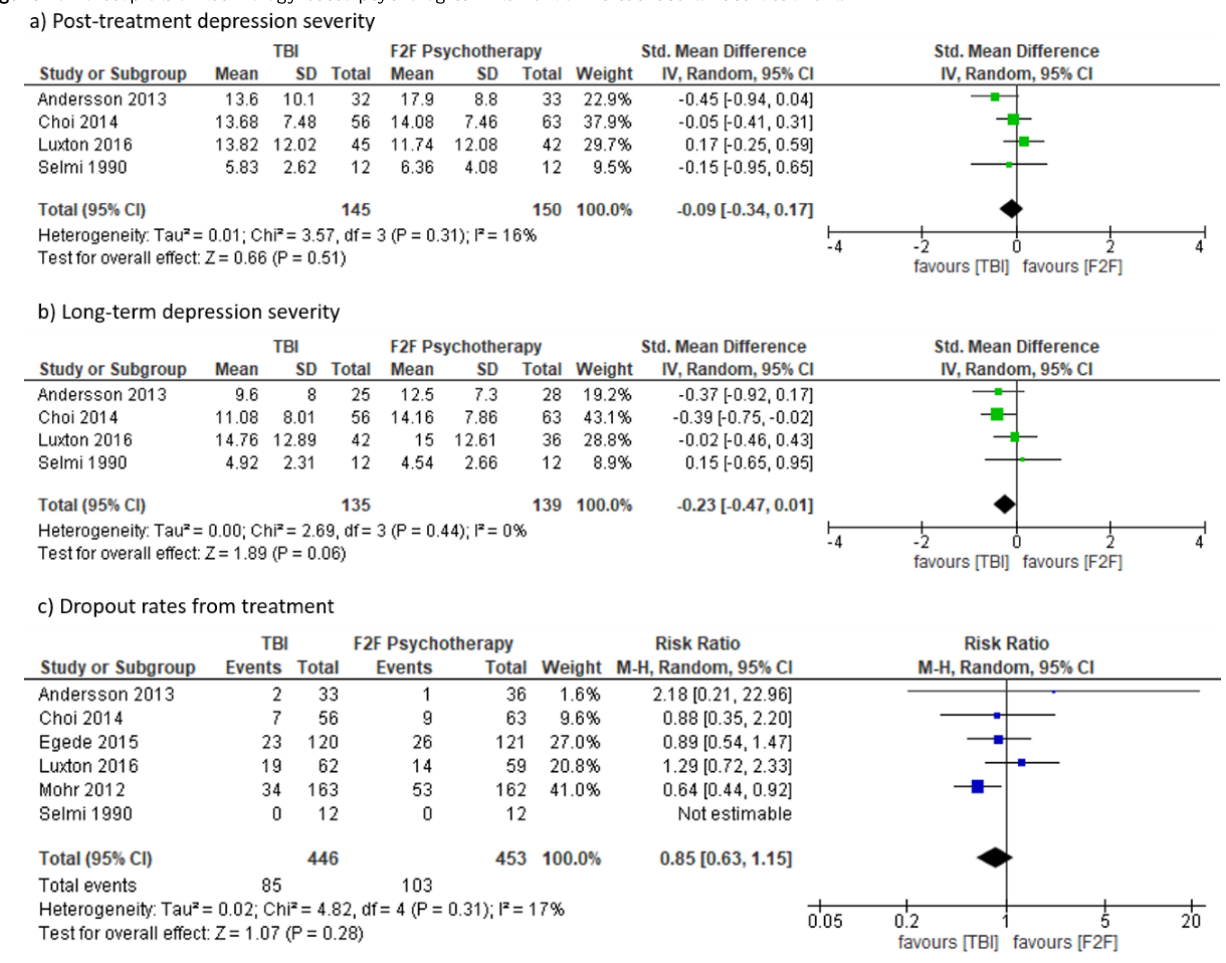
Figure 4. Forest plots on technology-based psychological intervention versus